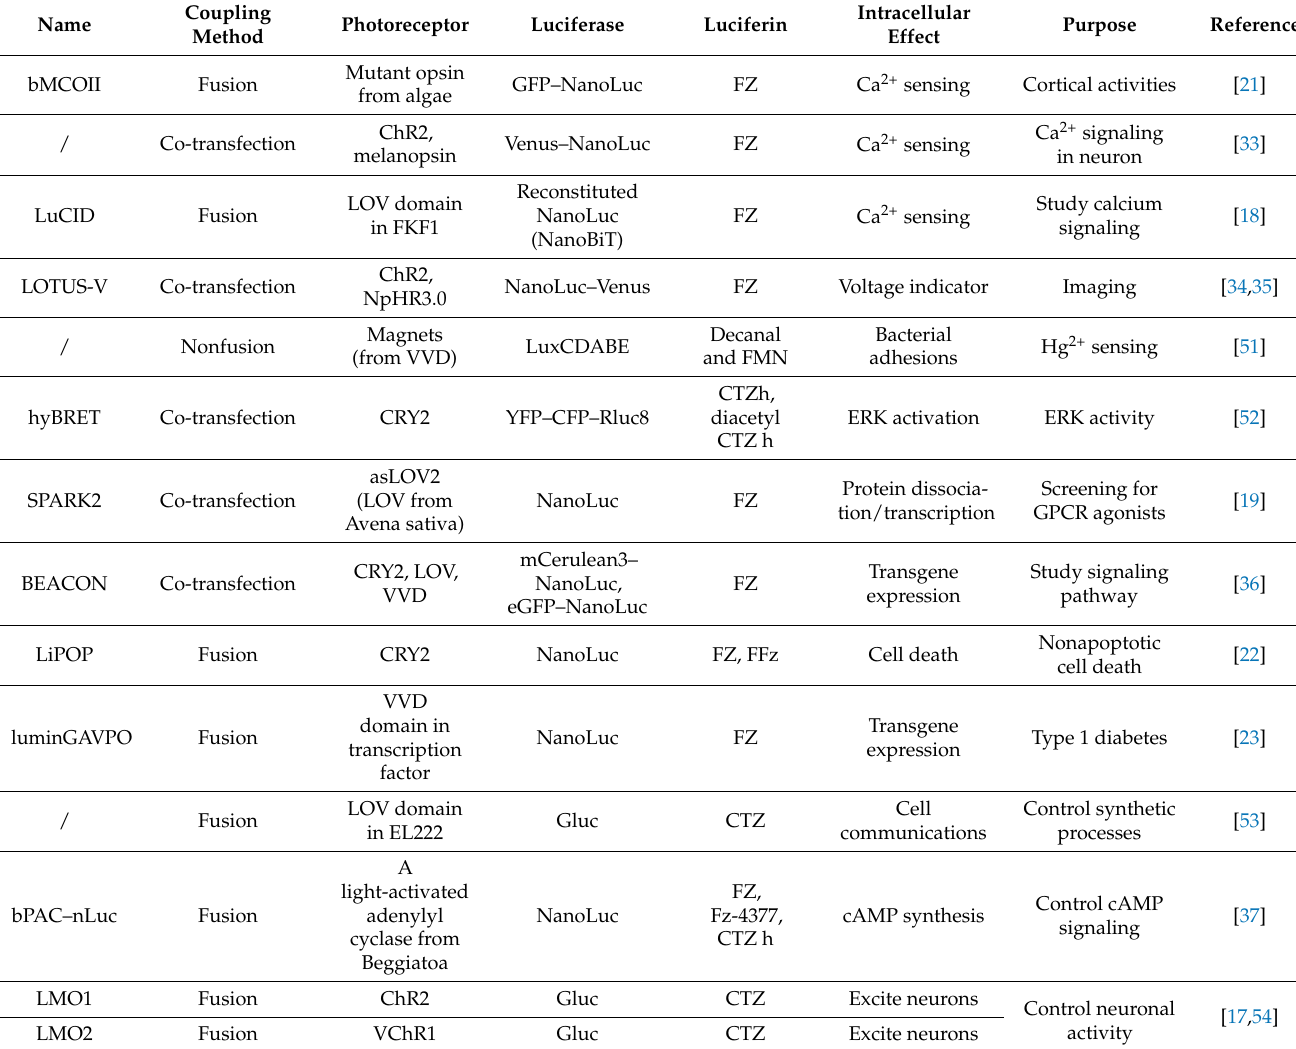
Table 1. The classic bioluminescence-induced optical probes mentioned in this